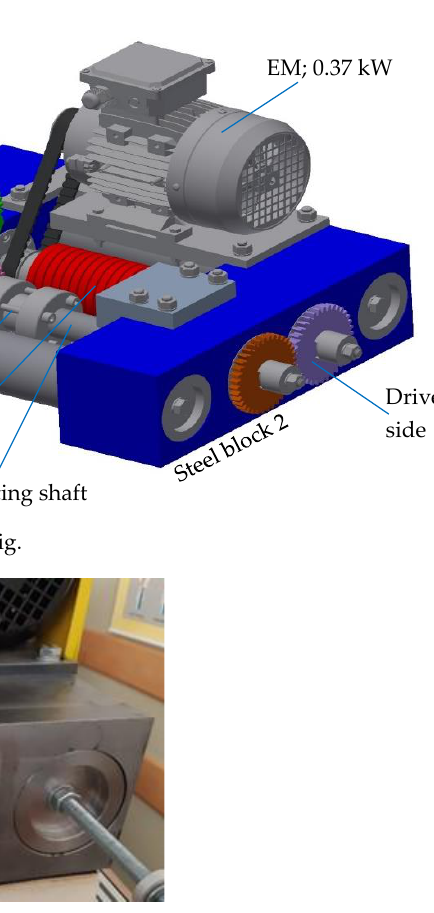
Figure 8. Measurement of the tooth thickness of a gear.